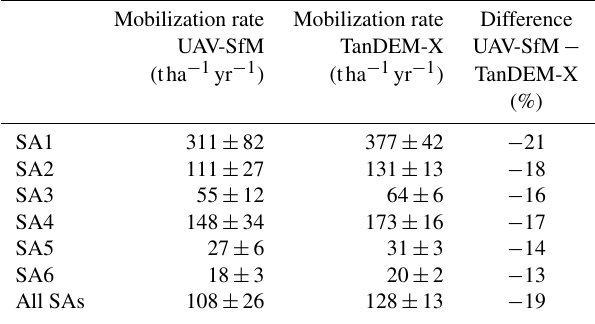
Table 2. Lavaka mobilization rates 1949–2010s. Lavaka mobiliza- tion rates (in tha − 1 yr − 1 ) obtained by applying the area–volume relationships from the UAV-SfM (Eq. 5) and TanDEM-X (Eq. 6) DEM to the lavaka areas for the longest time period available: 1949–2010s for SA1–5 and 1969–2010s for SA6. Reported values give the median and standard deviation from the 10 4 Monte Carlo simulations where the uncertainties in the fitted a and b coefficients of the area–volume relationships are accounted